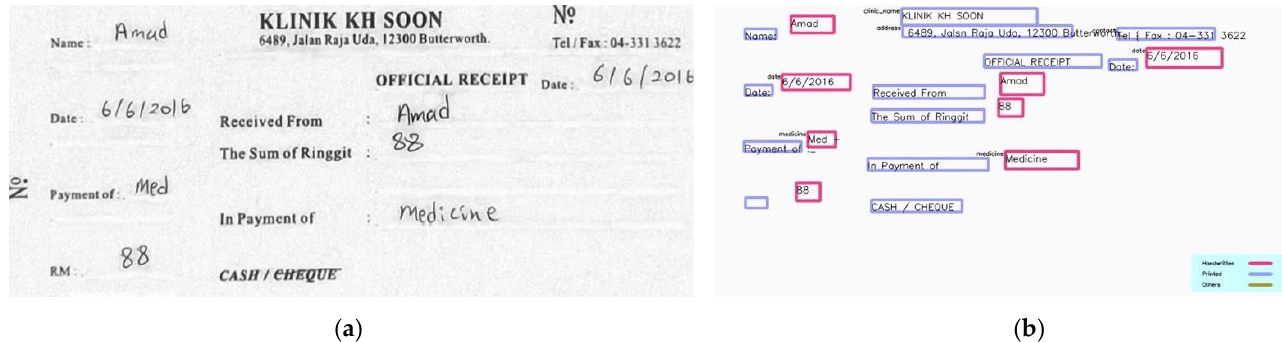
Figure 13. Sample input and output II: ( a ) input; ( b ) output.